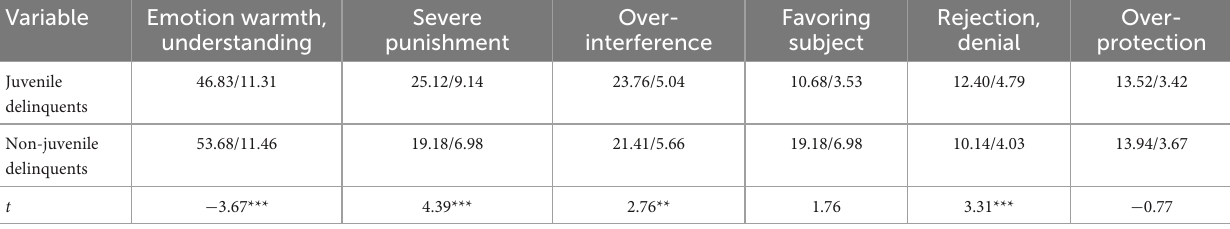
TABLE 3 Comparison of different dimensions of family rearing style (father) between juvenile delinquents and non-juvenile delinquents (M ± SD, n = 112). Variable